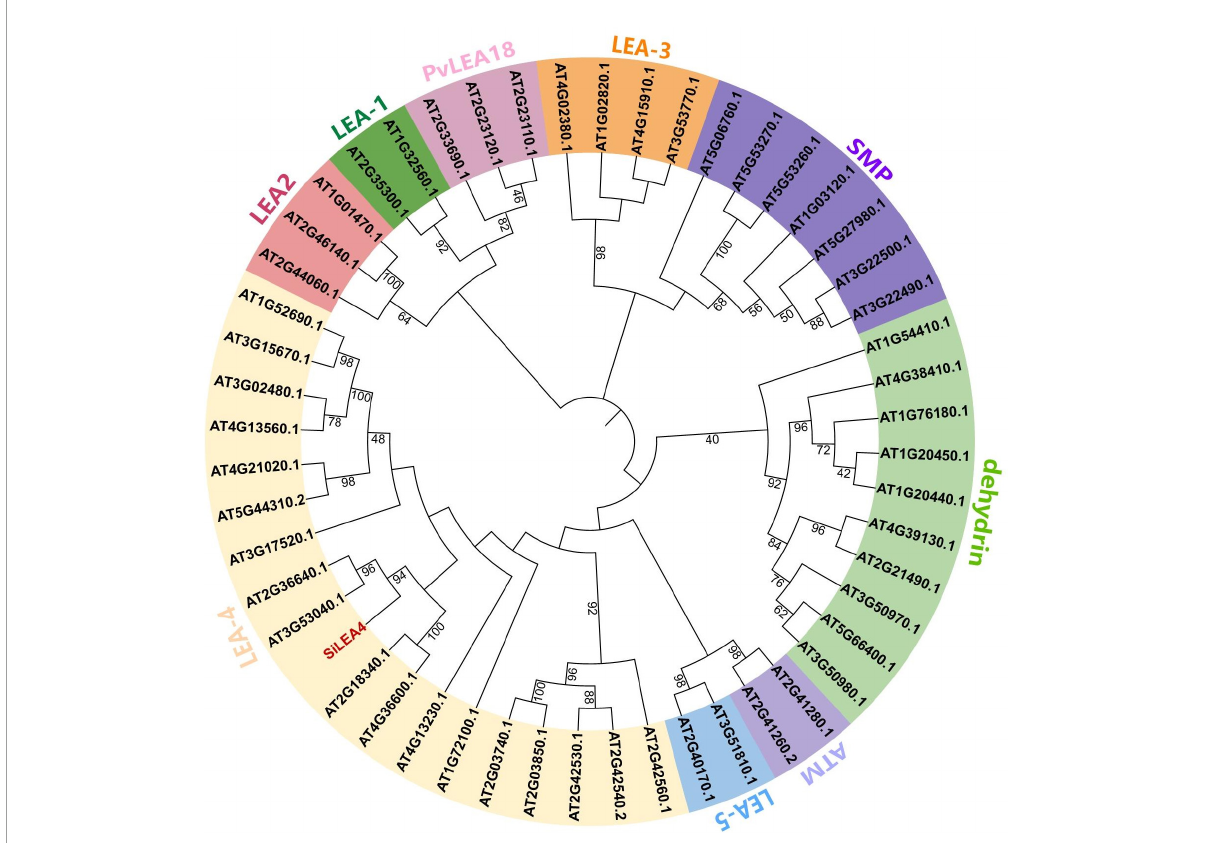
FIGURE1 Phylogenetic analysis of SiLEA4 gene. LEA proteins of other plant species included Arabidopsis thaliana , Artemisia annua (PWA93397.1), Citrus sinensis (XP_015386949.1), Daucus carota (BAJ08390.1), Olea europaea var. Sylvestris (XP_022863156.1), Pistacia vera (XP_031252570.1), Quercus lobata (XP_030927649.1), Betula platyphylla (AST13894.1), Eucalyptus grandis (XP_039174169.1), Eutrema salsugineum (XP_006410837.1), Brassica napus (XP_013679752.1), Brassica rapa (XP_009148762.1), Lupinus albus (KAE9621787.1) with Saussurea involucrata LEA4 unrooted phylogenetic tree. The phylogenetic tree was built using MEGA 6.0 by the Neighbor-Joining method with 1000 bootstrap